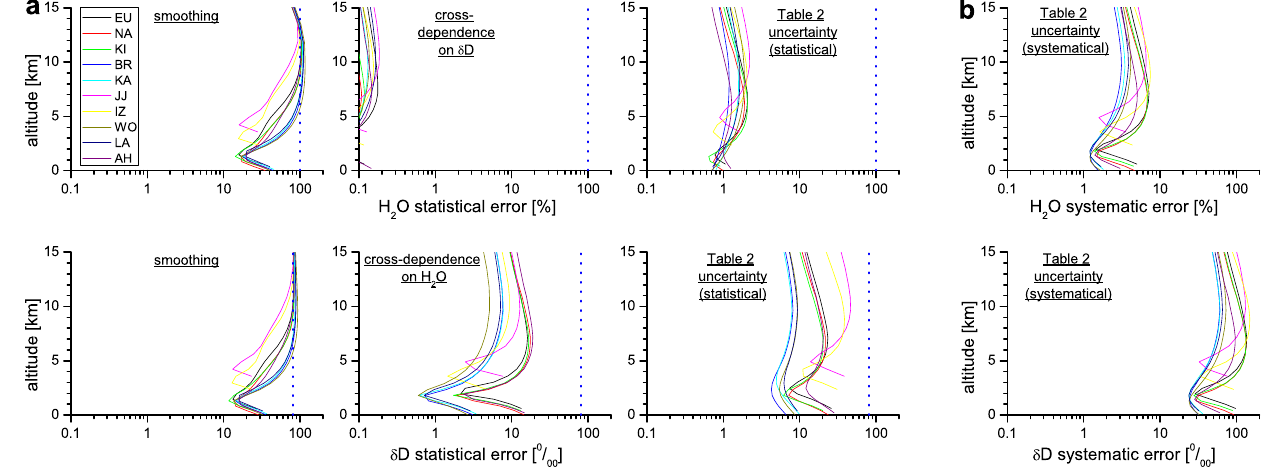
Fig. 9. Same as Fig. 8 but for H 2 O (top plots) as well as δ D (bottom plots) and after applying the a posteriori operator of Eq. (14). error is smaller than 50 %, even up to 10 km. Compared to this good sensitivity, the error due to cross-dependence on atmospheric δ D variations can be neglected (central plot of panel (a)). The right plot of panel (a) depicts the mean total errors as estimated for the statistical uncertainty sources of Table 2. This error is smaller than 10 % for all stations and throughout the troposphere. Panel (b) shows the mean total error estimations for the systematic uncertainty sources of Table 2. As documented in panel (b) of Fig. 5, this total error is dominated by an uncertainty in the applied spectroscopic line